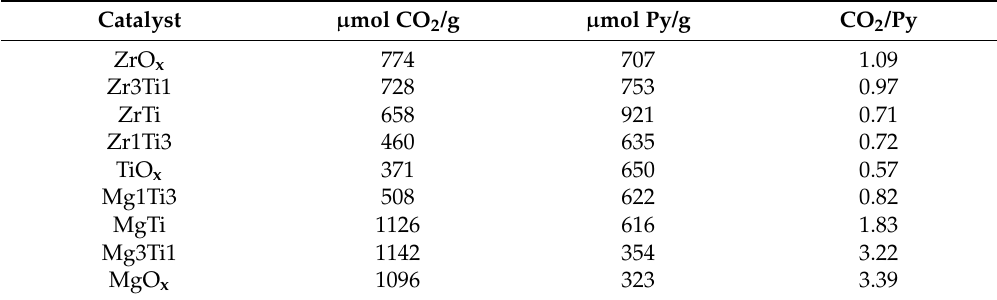
Table 2. Acid–base characteristics of the solids as determined by CO 2 -TPD and Py-TPD, respectively.